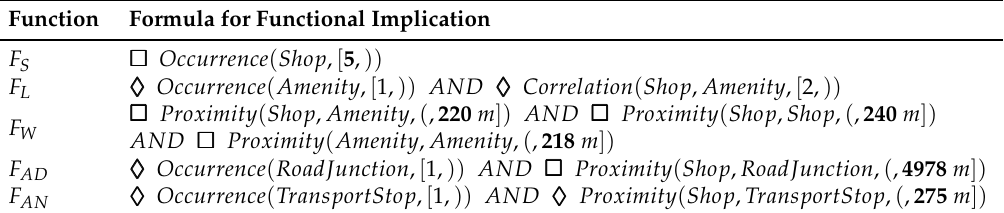
Table 6. Empirical pattern for places functioning as shopping